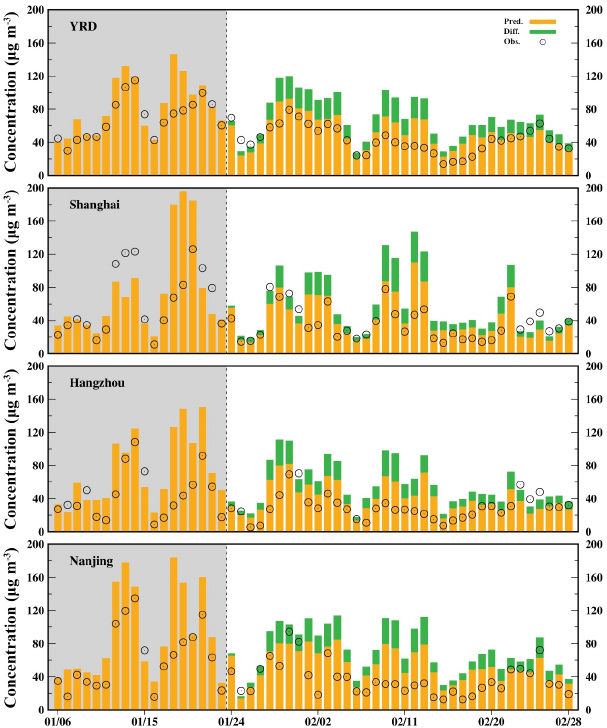
Figure 1. Predicted daily PM 2 . 5 , with observed daily PM 2 . 5 , in the YRD, and three major cities in case 2 (orange histogram) before (shaded area) and during (white area) the lockdown period. The green histogram (Diff.) represents the concentration difference in PM 2 . 5 , which is calculated as case 1 − case 2. Units are in micron grams per cubic meter (µgm − 3 ). Pred. is the predicted PM 2 . 5 con- centration, and Obs. is the observed PM 2 . 5